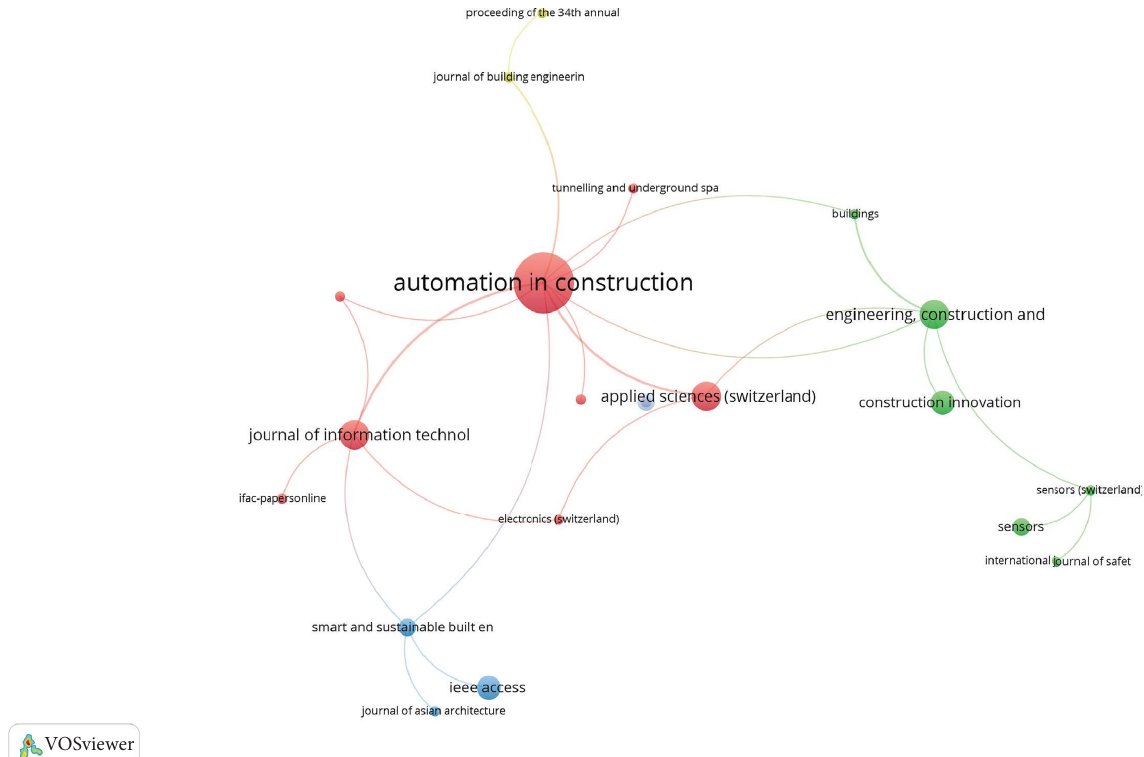
Figure 8: Digital Twin for AEC-FM activities uses scientifc-based mapping of infuencer